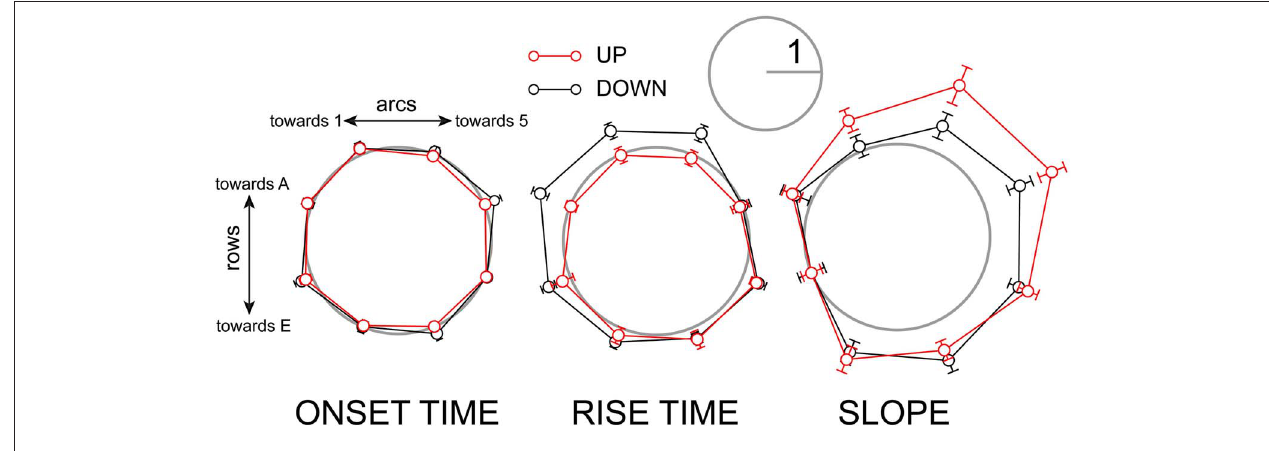
FIGURE 8 | Polarity of depolarizing response timing is accentuated in the up-state. Left : population radial plot of response onset time. Middle : population radial plot of response rise time. Right : population radial plot of response slope. Before